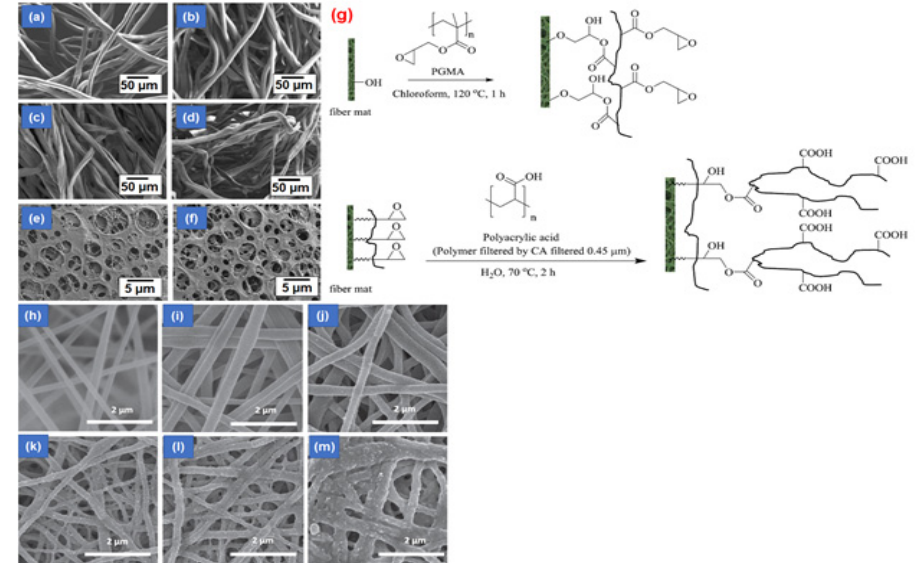
Figure 23. SEM images of ( a , b ) regenerated cellulose micro-fiber, ( c , d ) bleached cotton fiber, and commercially available cellulose membrane, ( e ) prior and ( f ) after surface functionalization with diethylaminoethyl [211]; ( g ) reaction of the regenerated cellulose membrane with PAA and PGMA; SEM images of the cellulose membrane ( h ) before and ( i ) after annealing, ( j ) after hydrolysis, ( k ) after immersing in the chloroform, ( l ) after modification by the poly(glycidyl methacrylate), and ( m ) after modification with the poly(acrylic acid) [115]. Reproduced with permission from [211] and [115], copyright of Elsevier.